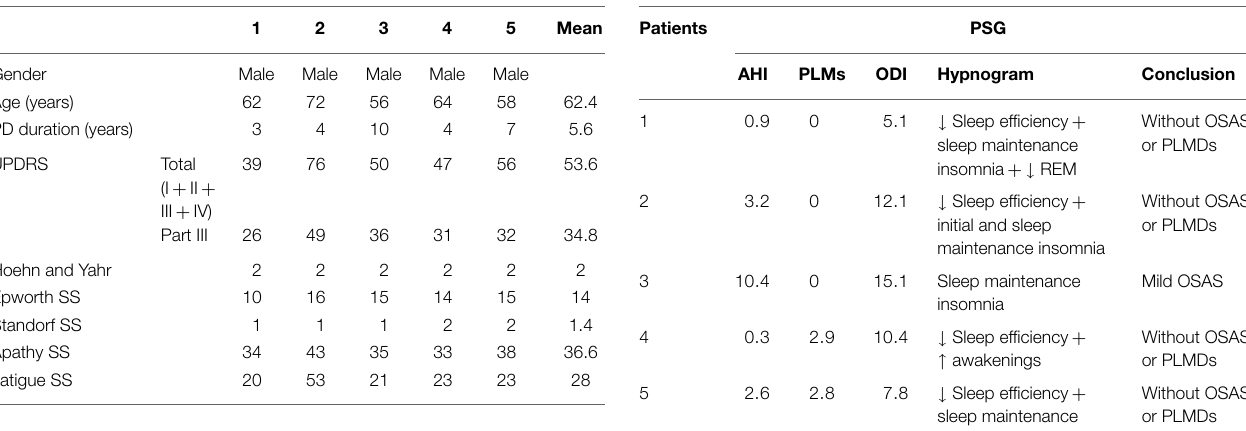
TABLE 1 | Clinical characteristics of patients . TABLE 2 | Ambulatory polysomnography results .